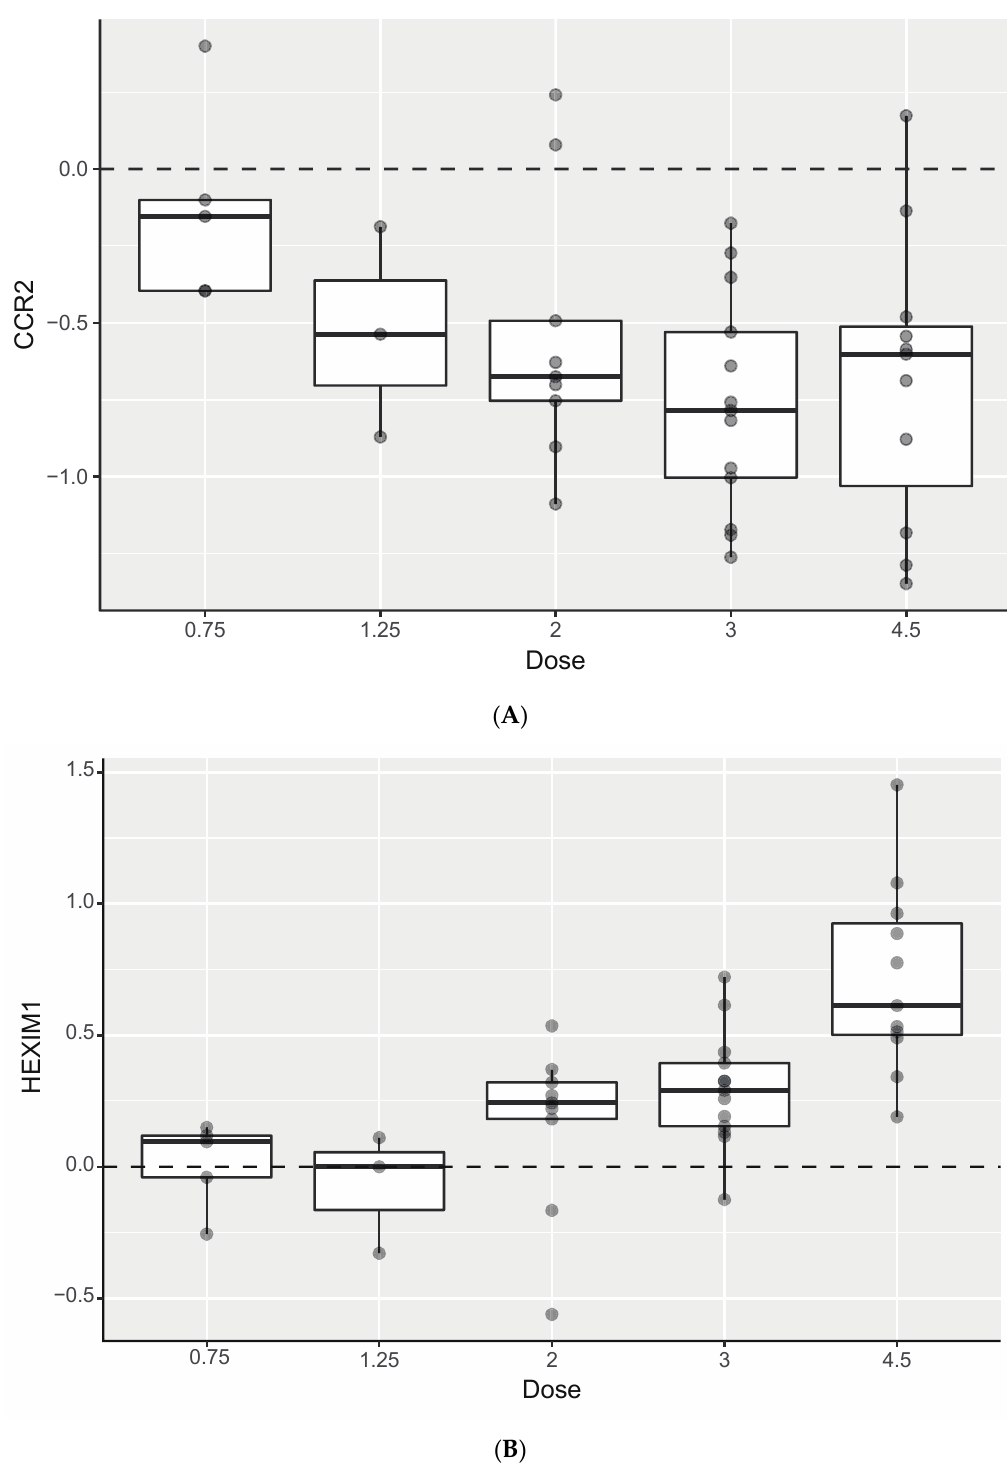
Figure 3. Changes from baseline in gene expression in tumor biopsies by dose on schedule A in ( A ) CCR2 and ( B ) HEXIM1 . Center lines in the boxes represent the median value, the top and bottom of the boxes show the interquartile range (IQR), the vertical bars indicate 1.5 × IQR, and each dot represents one sample.